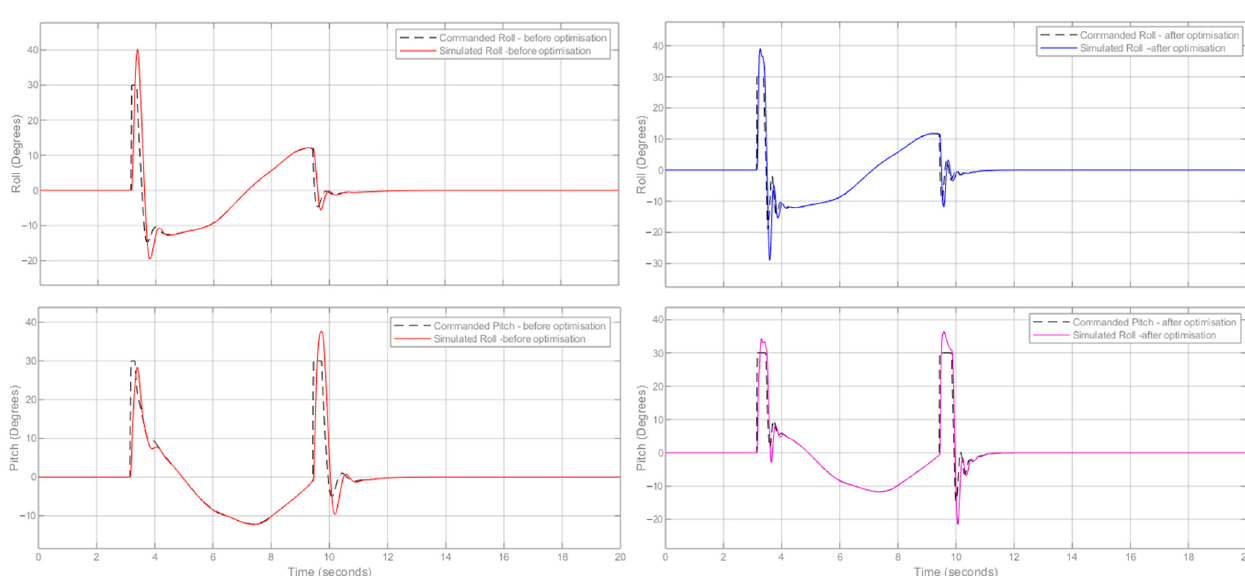
Figure 10. Control performance in the desired trajectory.